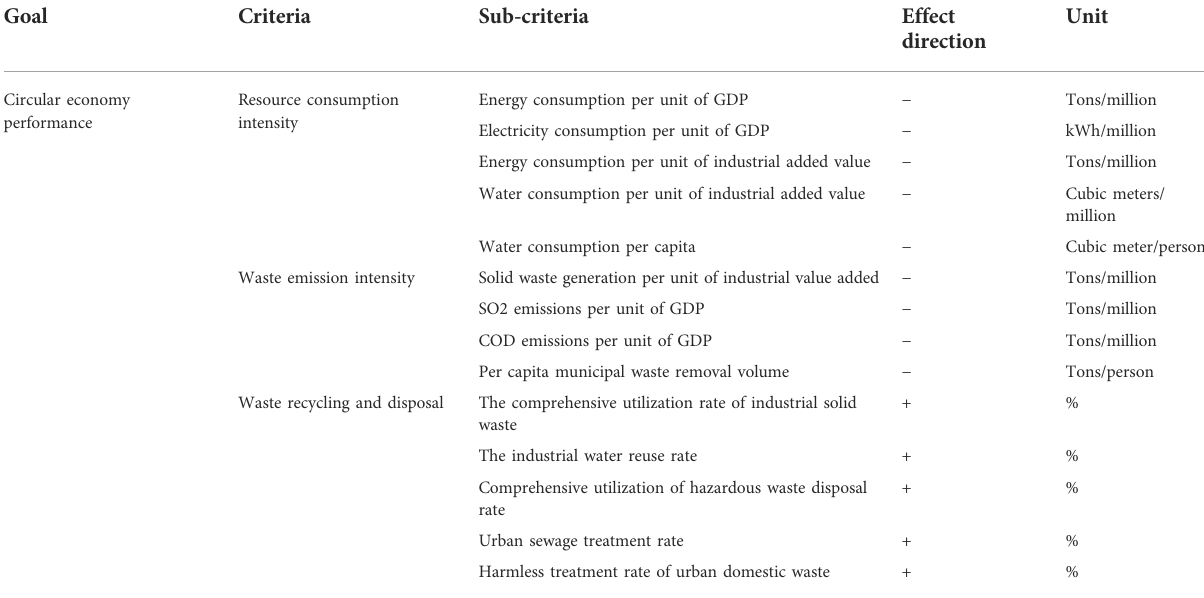
TABLE 1 Provincial circular economy performance evaluation index